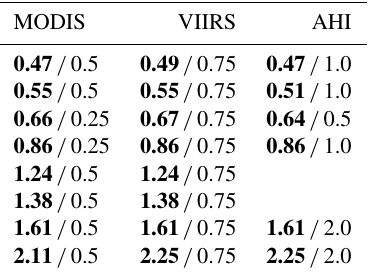
Table 1. MODIS, VIIRS, and AHI wavelengths in micrometers used directly in the DT algorithm (bold) and subsatellite point spa- tial resolution in kilometers. The table presents native resolution of sensors, but this study uses a special run of AHI where all spectral channels were reduced to a resolution of